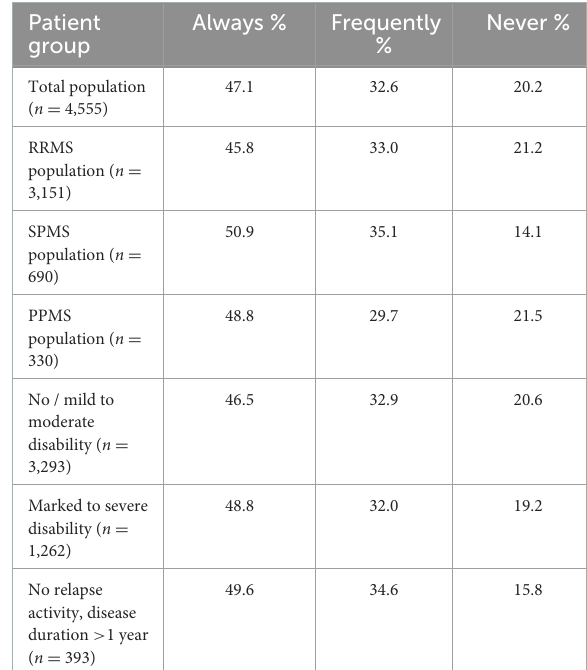
TABLE 3 Frequency of contrast agent use for MRI. Patient